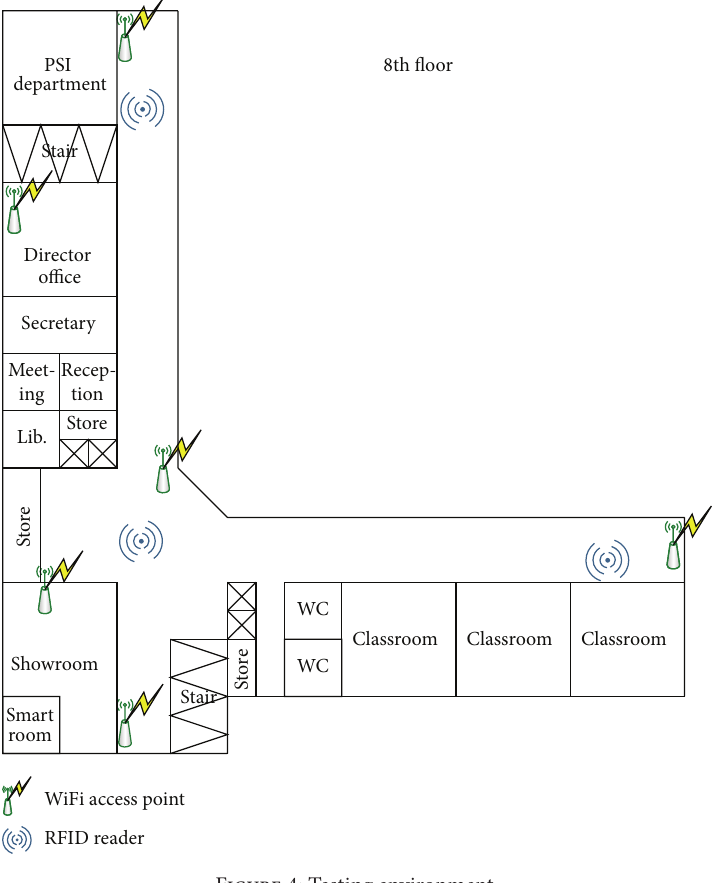
Figure 4: Testing